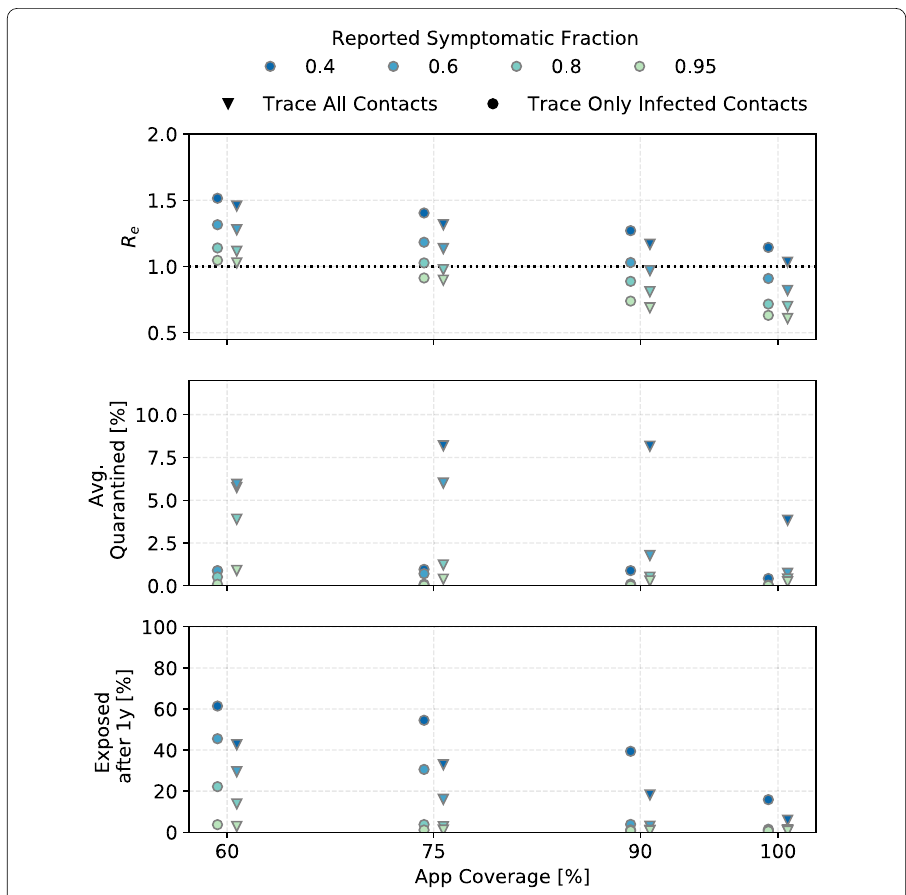
Figure 8 The same as Fig. 7 but for starting conditions where R = 2. R = 2 could be achieved by interventions other than DCT